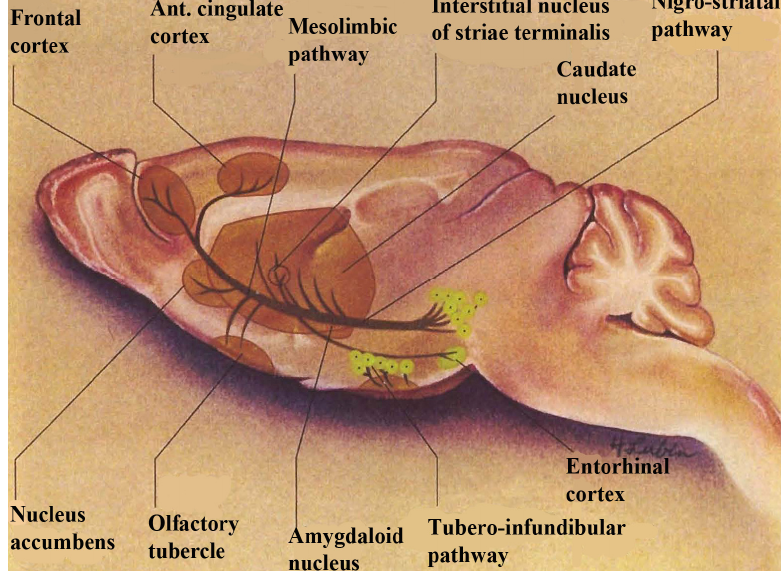
Figure 1. A schematic diagram showing dopamine in nigrostriatal and mesocorticolimbic pathways in basal ganglia. Note: this figure is adapted with permissions from